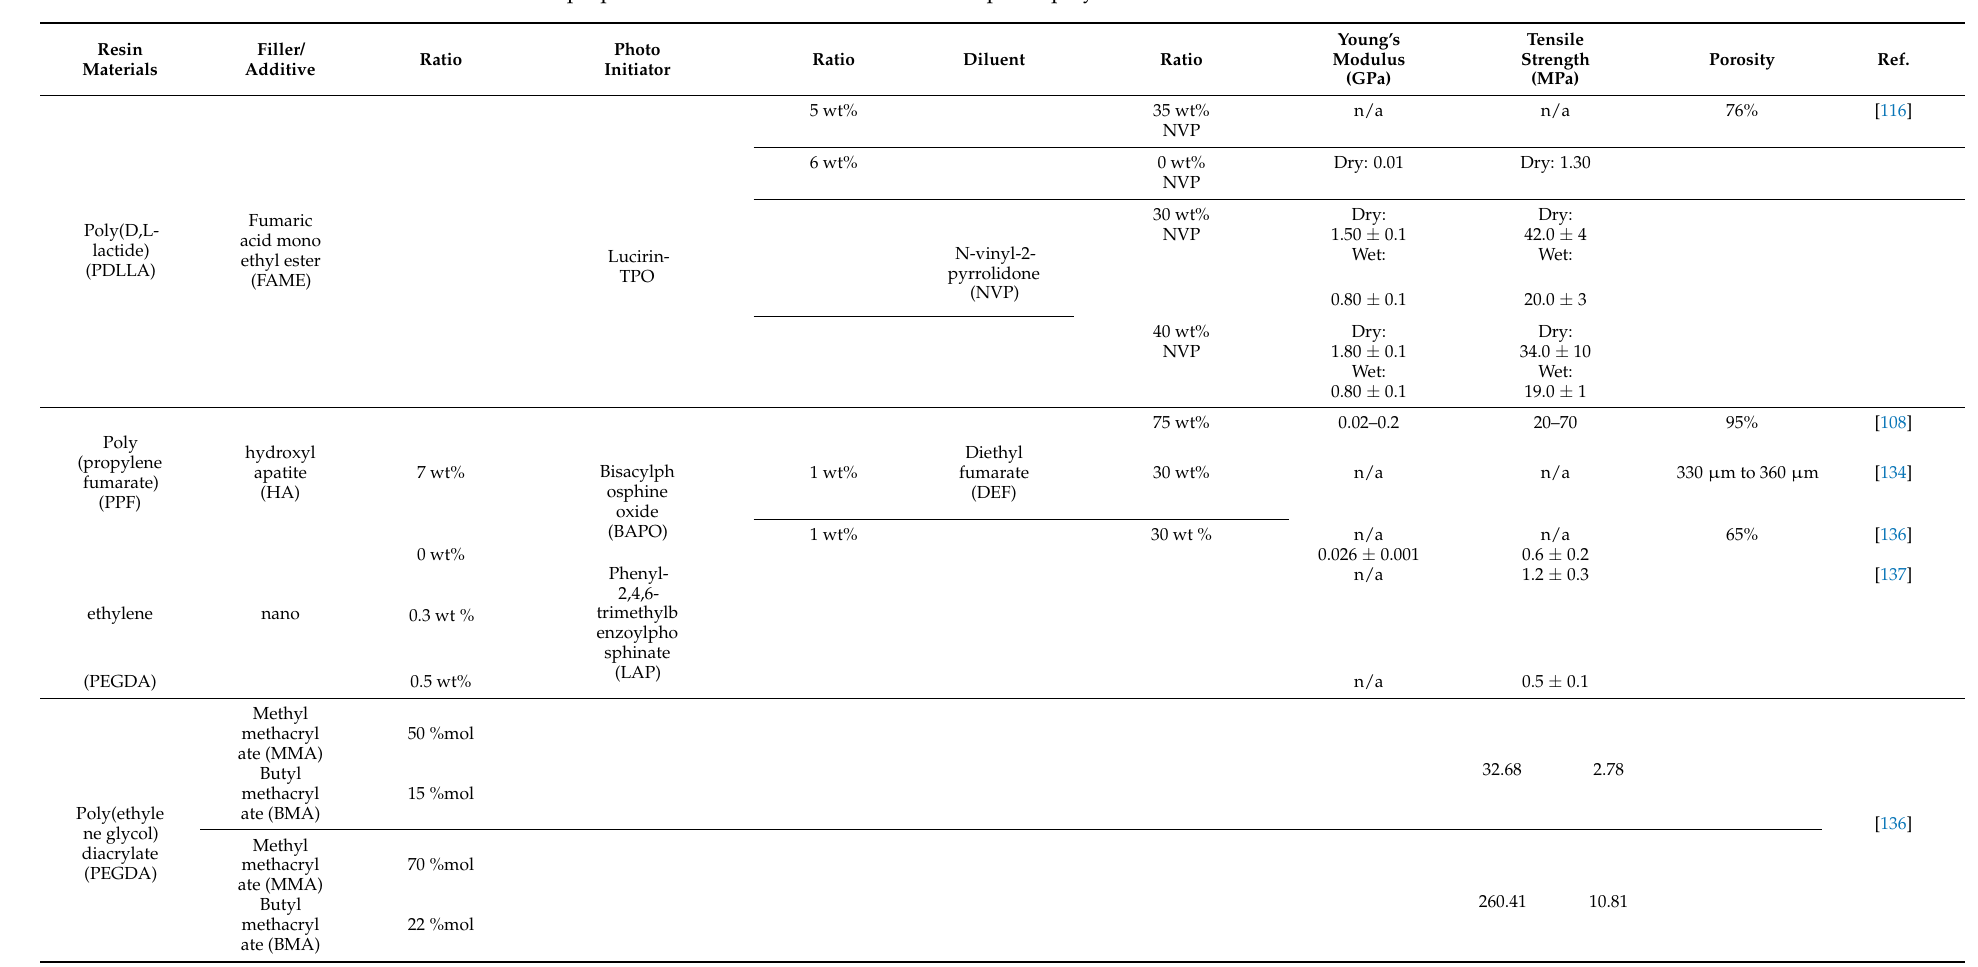
Table 6. Mechanical properties of various biomaterial resins for photo-polymerization 3D TE